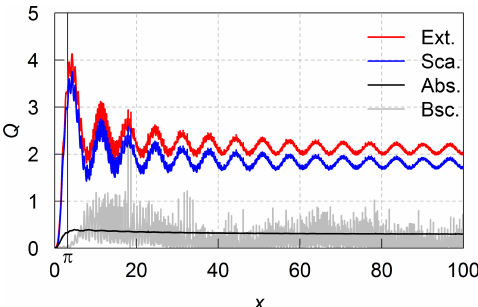
Figure A1. Mie-based particle light extinction, scattering, absorp- tion, and backscatter efficiency ( Q ext , Q sca , Q abs , and Q bsc ), de- pending on the size parameter x of layered aerosol particles with a core of eBC and a shell for a wavelength of 355nm. The volume fraction of eBC is 0.05. The refractive index of core and shell were taken from Table